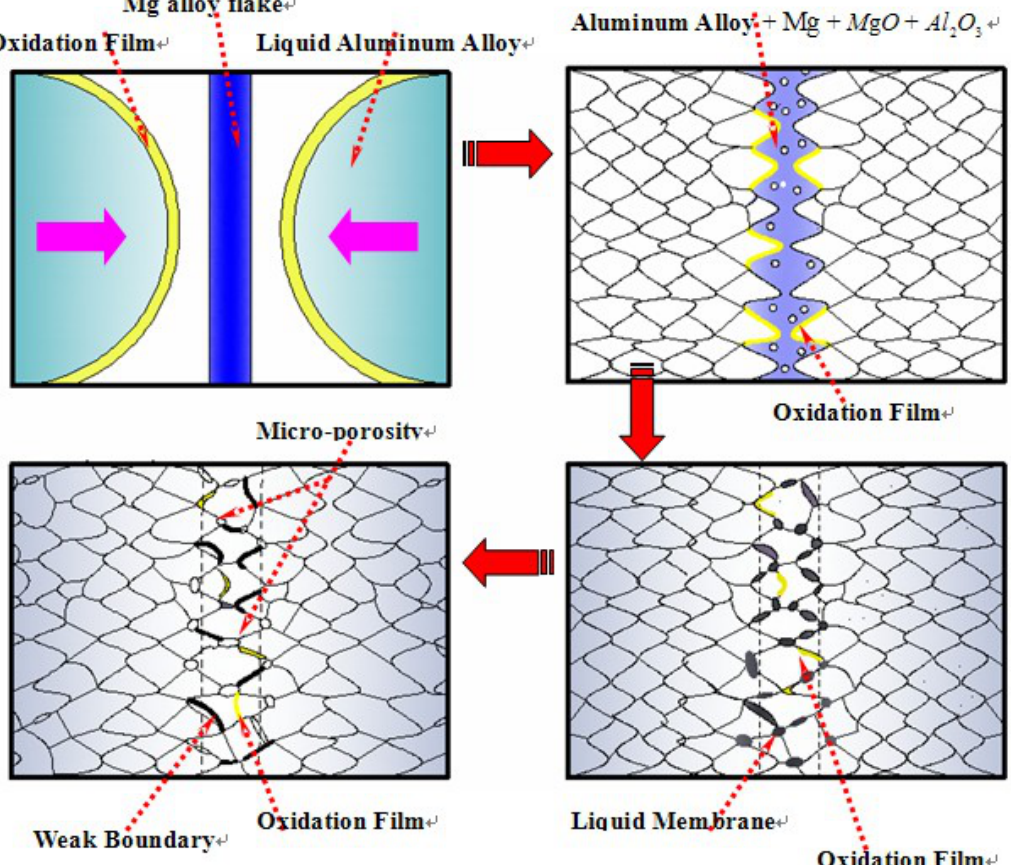
Figure 14. Sketch of fracture splitting surface forming process.